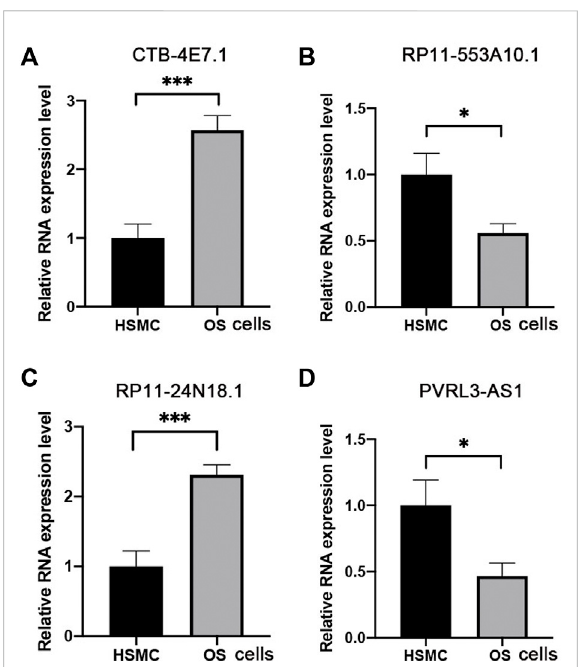
FIGURE 7 Expression level of the four lncRNAs validated by RT-qPCR in osteosarcomatissues. (A) CTB-4E7.1; (B) RP11-553A10.1; (C) RP11- 24N18.1; and (D) PVRL3-AS1. Control (CON) is human skeletal muscle from trauma patients ( n = 10); OS, osteosarcoma tissues ( n = 15). Data are mean ± SD. * p < 0.05, ** p < 0.01, *** p < 0.001 (Student ’ s t -test).